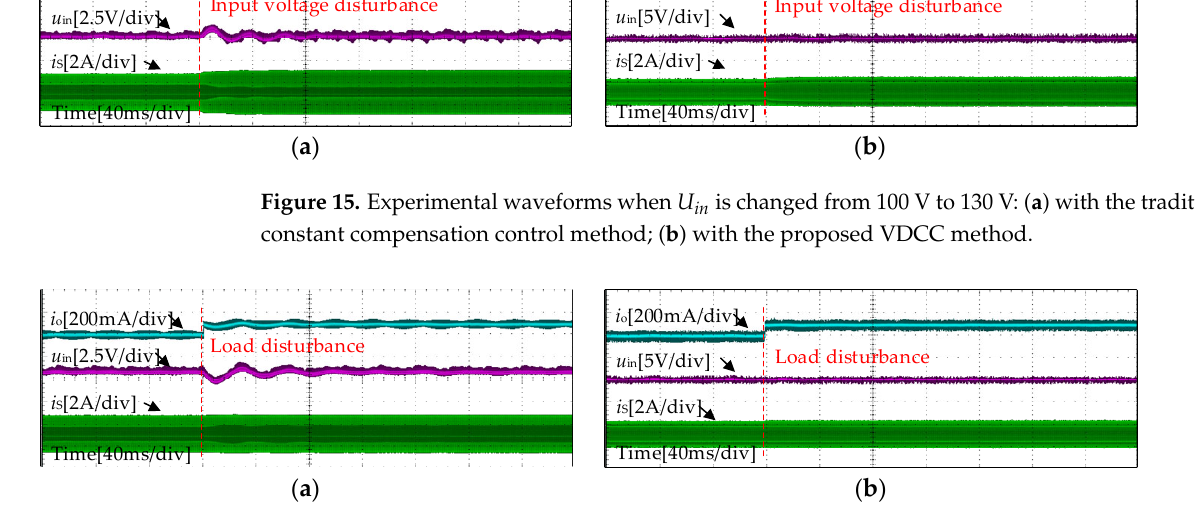
Figure 16. Experimental waveforms when Uin is changed from 100 V to 130 V: ( a ) with the traditional constant compensation control method; ( b ) with the proposed VDCC method.